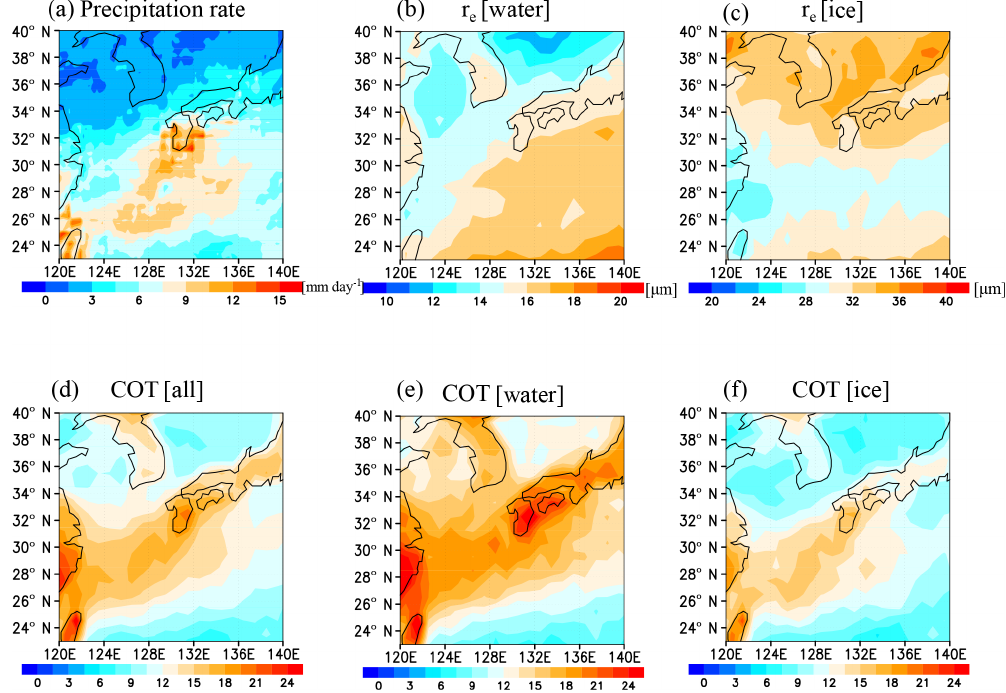
Figure 2. (a) Mean precipitation rate (mm day − 1 ) from TRMM. (b) Mean water cloud effective radius (µm), (c) mean ice cloud effective radius (µm), (d) mean all-cloud optical thickness, (e) mean water cloud optical thickness, and (f) mean ice cloud optical thickness for the target period using Aqua/MODIS